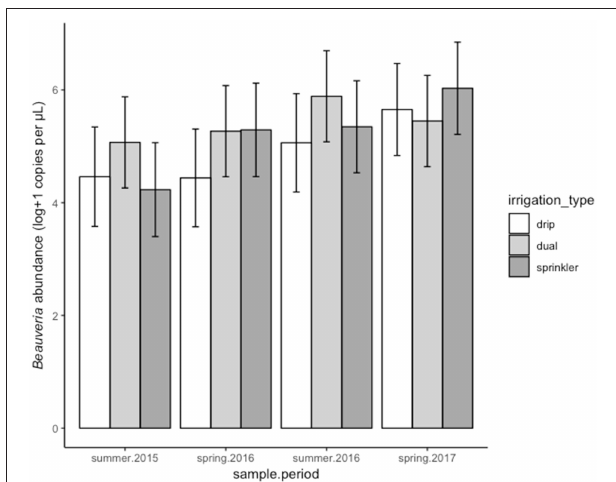
FIGURE 2 | Effect of irrigation type (shades) on Beauveria bassiana abundance across all sites at four sampling periods. Error bars indicate 95% confidence limits based on likelihood of these estimates within the final model, i.e., accounting for all other factors included in the model.